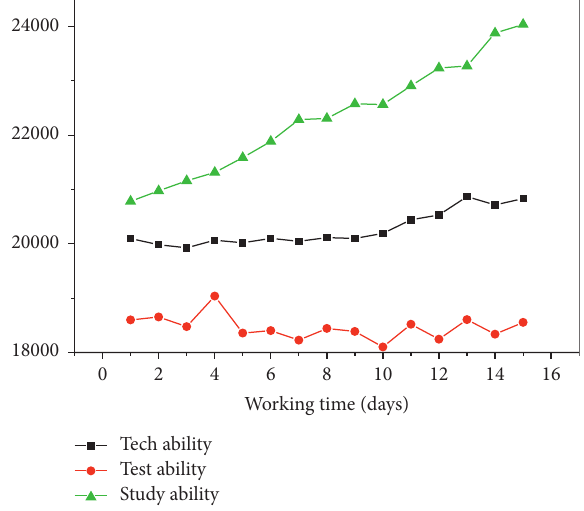
Figure 6: Algorithm training data set.